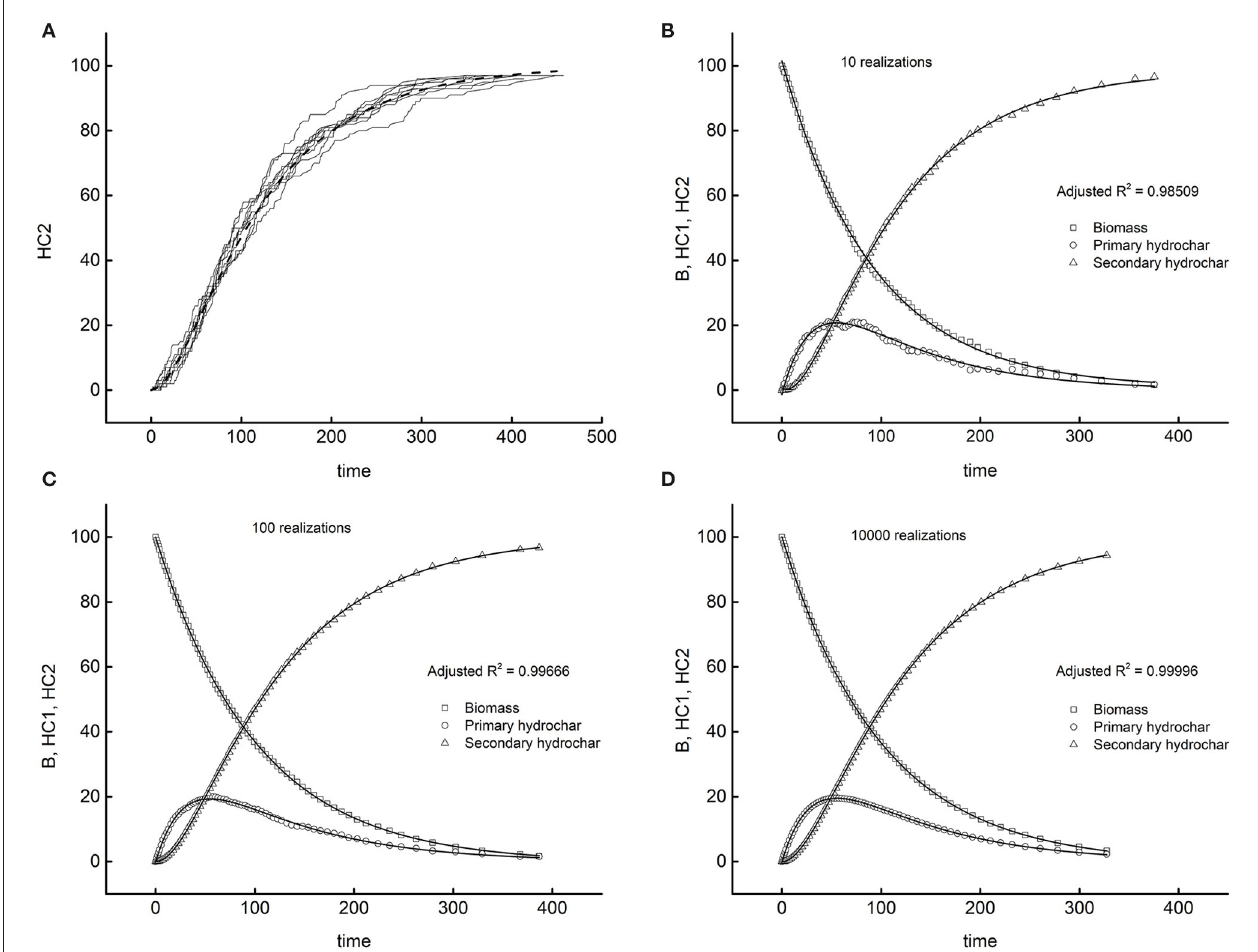
FIGURE 8 | The test bench of program (B) with scheme 1. Dashed lines, exact solutions; symbols, simulations. (A) Ten realizations of secondary hydrochar dynamics. Remaining diagrams (B–D) averages on increasing number of